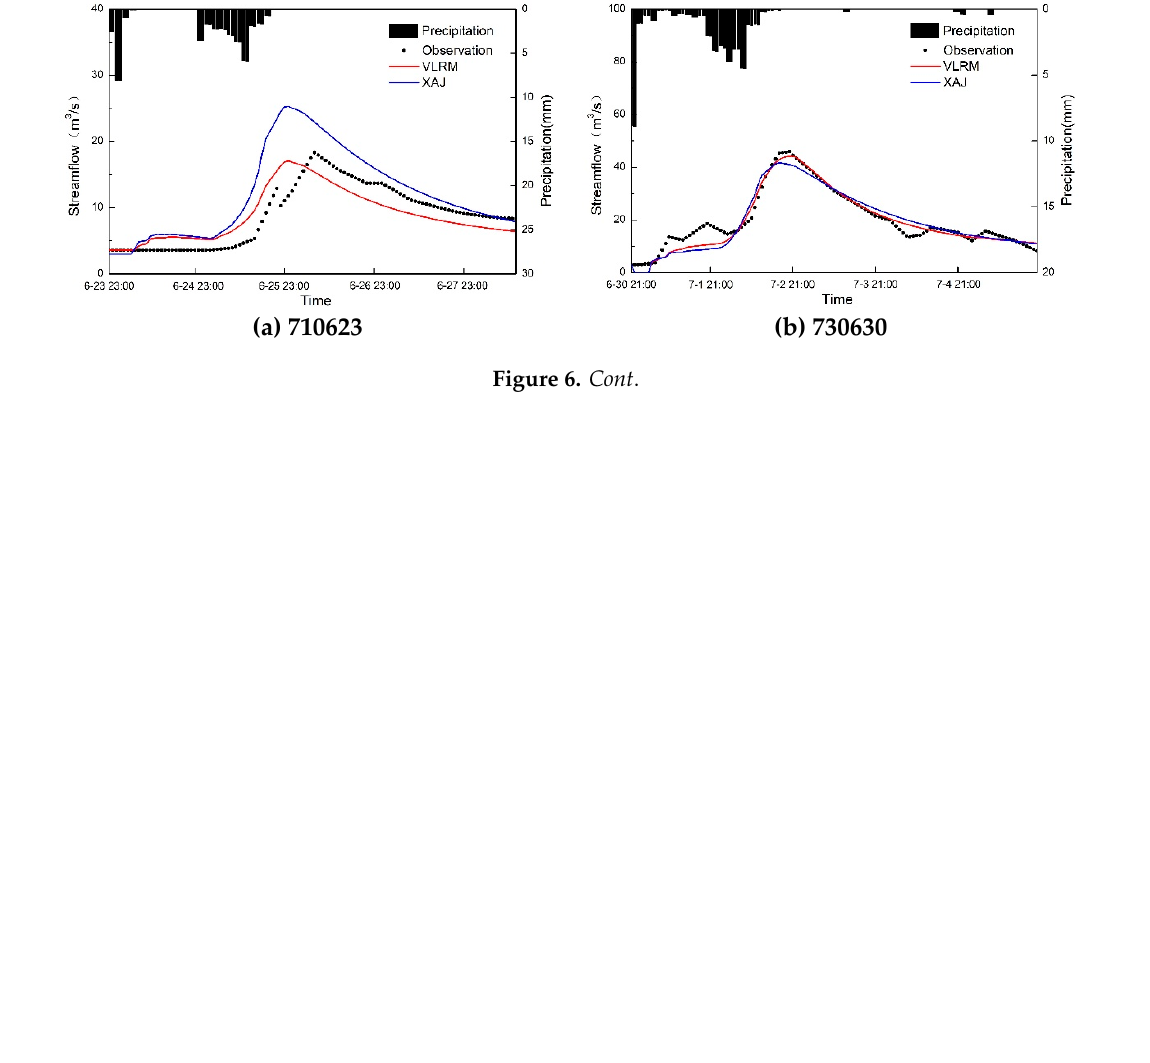
13 of 22 Figure 5. The average values of performance measures for Zijingguan basin in ( a ) calibration and ( b ) validation periods, and for Xiuwu basin in ( c ) calibration and ( d ) validation periods. Note that the RRD and RPF are the averages of the absolute values of RRD and RPF in Tables 2 and 3, respectively. Table 3. Performance measures of XAJ and VLRM models in Xiuwu Basin. Title